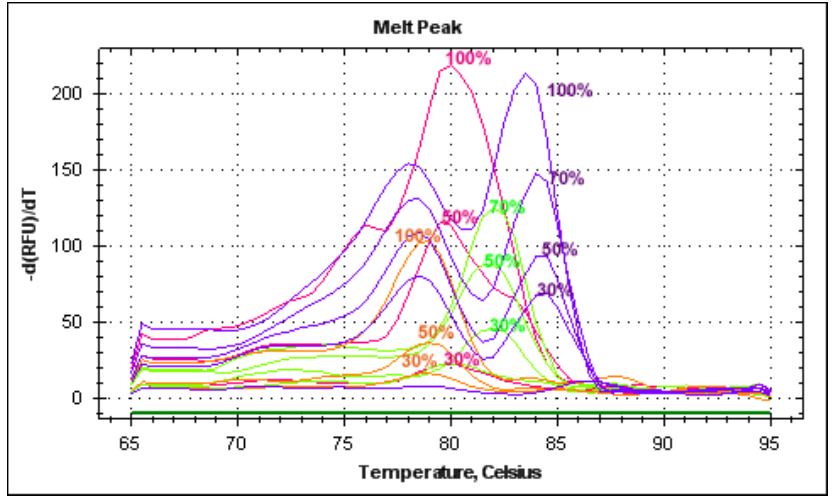
Figure 4. Melting peak profiles of real-time PCRs carried out on mixed juices with the new species-specific primer pairs.